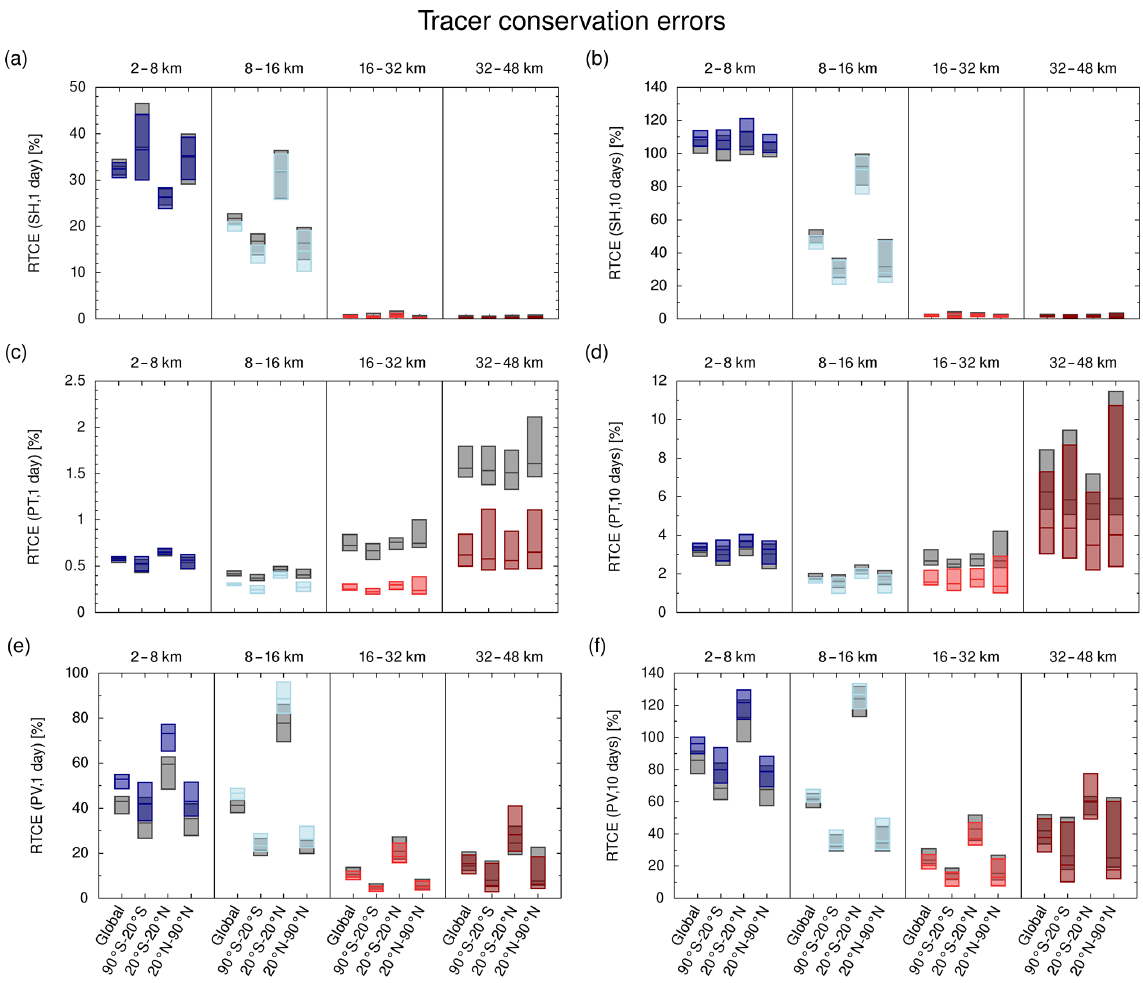
Figure 12. Tracer conservation errors of specific humidity (SH), potential temperature (PT), and potential vorticity (PV) in ERA5 (blue and red bars) and ERA-Interim (dark gray bars) after 1 day (a, c, e) and 10 days (b, d, f) of simulation time. Bars indicate the peak-to-peak range and the median of 24 trajectory simulations covering the year